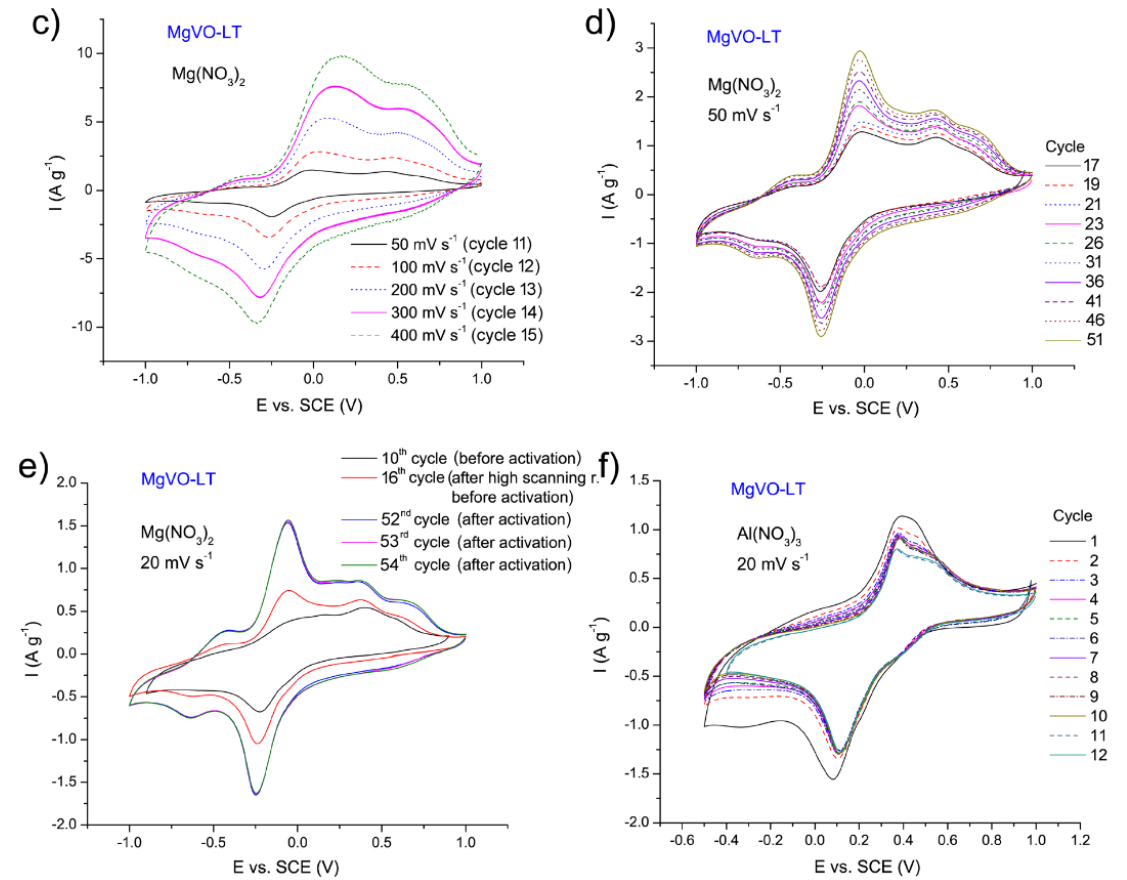
Figure 4. Cyclic voltammograms of MgVO-HT in 3M Mg(NO 3 ) 2 at 20 mVs −1 ( a ); MgVO-LT in 3M Mg(NO 3 ) 2 at 20 mVs −1 ( b ) and at higher scanning rates ( c ) before activation; activation of the MgVO-LT in 3M Mg(NO 3 ) 2 at 50 mVs −1 ( d ); MgVO-LT in 3M Mg(NO 3 ) 2 at 20 mVs −1 before and after activation ( e ); MgVO-LT in 1M Al(NO 3 ) 3 at 20 mVs −1 ( f ).